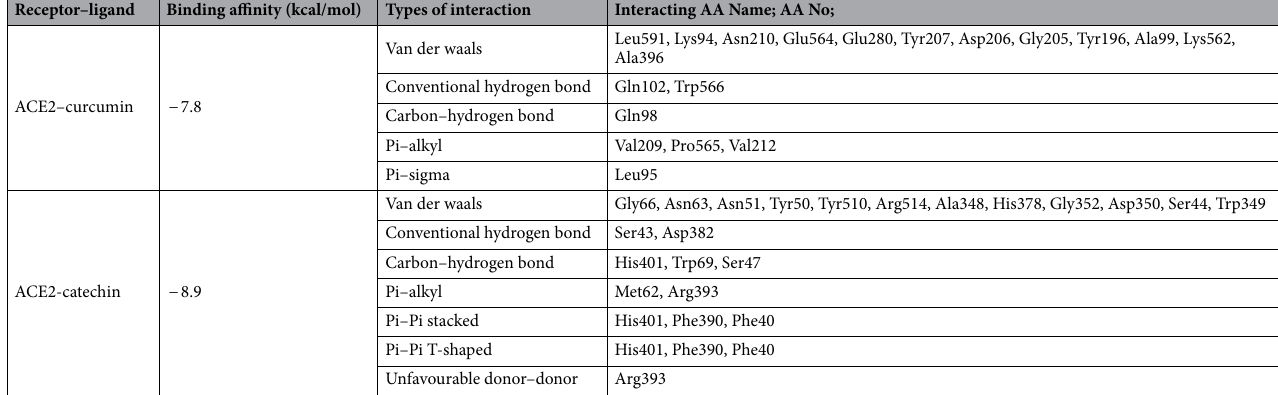
Table 3. The binding energy, types of interaction and amino acids involved in the interaction of human ACE2 receptor with curcumin and catechin.